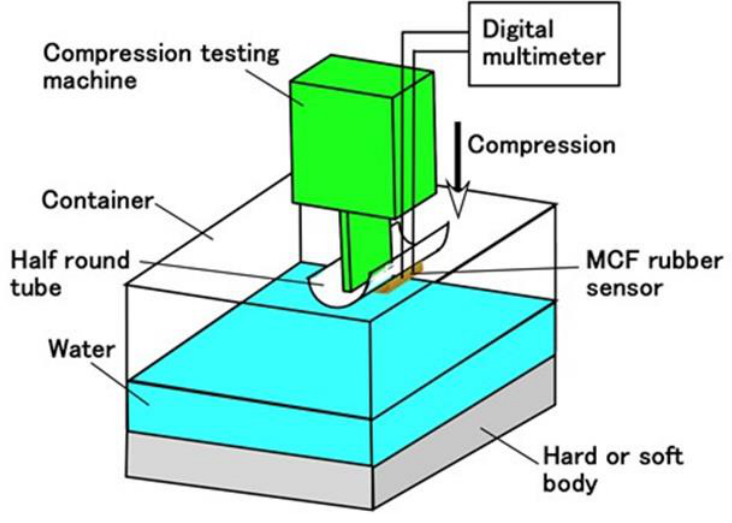
Figure 14. Schematic diagram of sensitive MCF rubber sensor in water under compression.